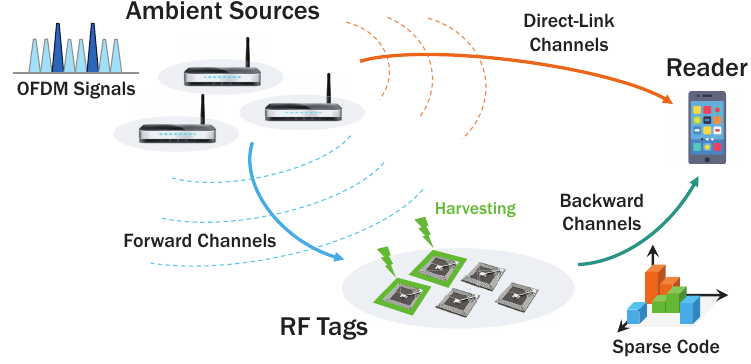
Figure 1. System architecture of MSC-AmBC over multiple OFDM